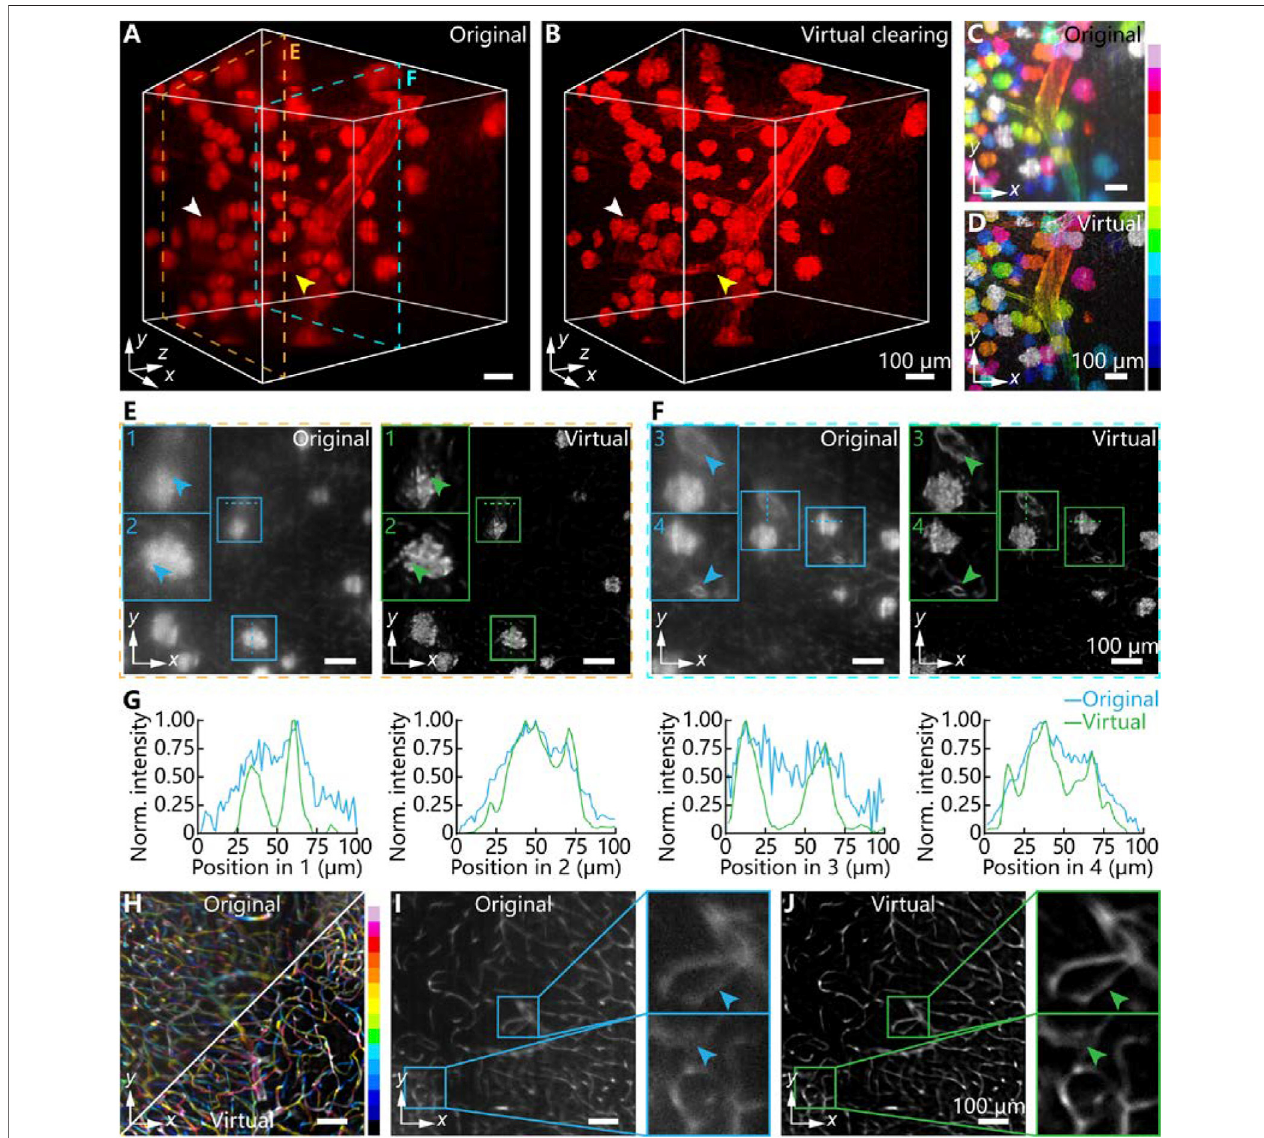
FIGURE4| Thevirtualopticalclearingeffectformillimeter-thicknessmousetissues. (A) 3D fl uorescenceimageofimperfectlyclearedmousekidneytissue.Thetwo dashed boxes represents 2D sections from two imaging depths (B) 3D fl uorescence image of virtually optically cleared mouse kidney tissue by using 3D-VoCycleGAN. Thewhiteandyellowarrowsrepresentstheglomerulusandarterybranch,respectively. (C,D) Thedepthcolor-codedimageofimagevolumein (A) and (B) ,respectively. (E) The comparison results between original image and virtually cleared image for shallow depth shown in (A) . The magni fi cations of insets were ×2. (F) The comparisonresultsbetweenoriginalimageandvirtuallyclearedimagefordeepdepthshownin (A) .Themagni fi cationsofinsetswere×1.5.Theblueandgreenarrowsin (E) and (F) representedthestructure detailsofglomeruli andarterybranch, respectively. (G) Thequantitativeevaluationoftissuestructuraldetails. Theplottingcurvesof four groups of line pro fi les represented the glomeruli and artery branch (H) The comparison results between original and virtually cleared mouse brain vessels by using depth color-coded z-projections. (I) The original 2D image showing blurred brain vessels (J) The 2D image corresponding to image (I) after virtual optical clearing. The blue and green arrows represented the brain vessel details. The magni fi cations of insets were ×3.